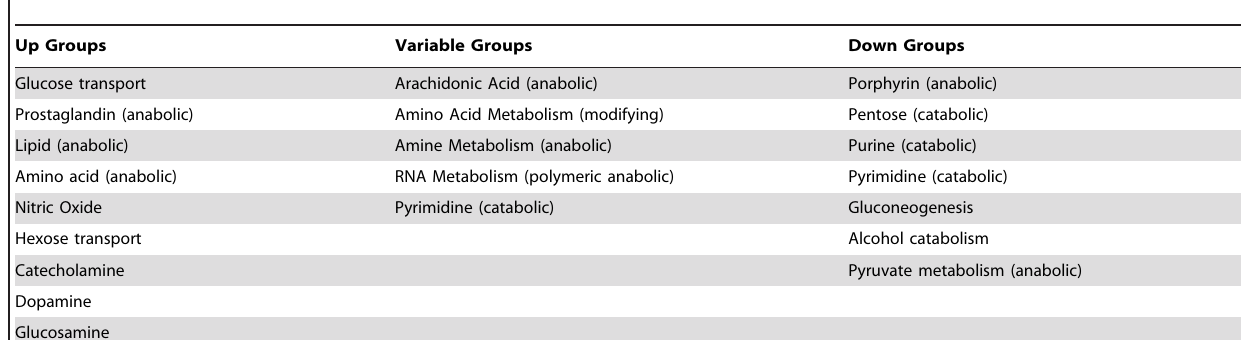
Table 1. Variations in Metabolic Activities in the General Temporal Groupings